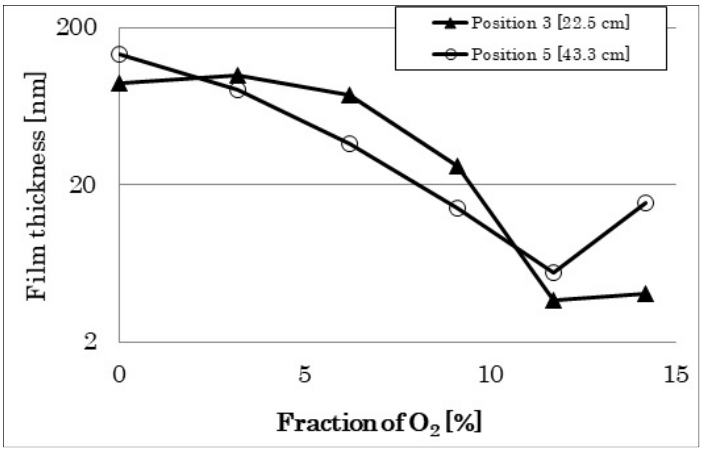
Figure 4. Relation between the film thickness and the fraction of O 2 (%) in the case without the Al auxiliary outer anode at the axial positions of 22.5 and 43.3 cm from the edge of the glass tube.